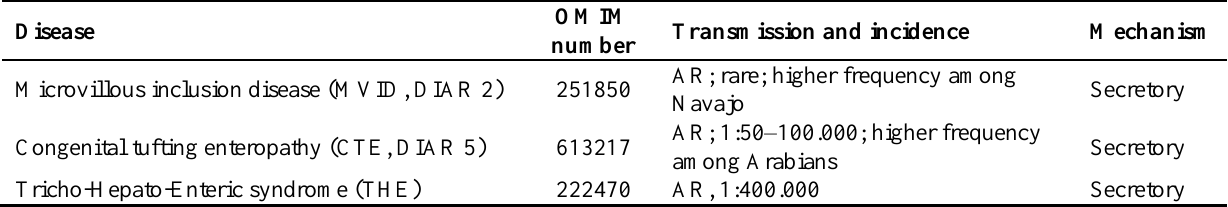
Table 2. Inheritance, epidemiology and main pathological mechanisms of the defects of enterocyte differentiation and polarization.